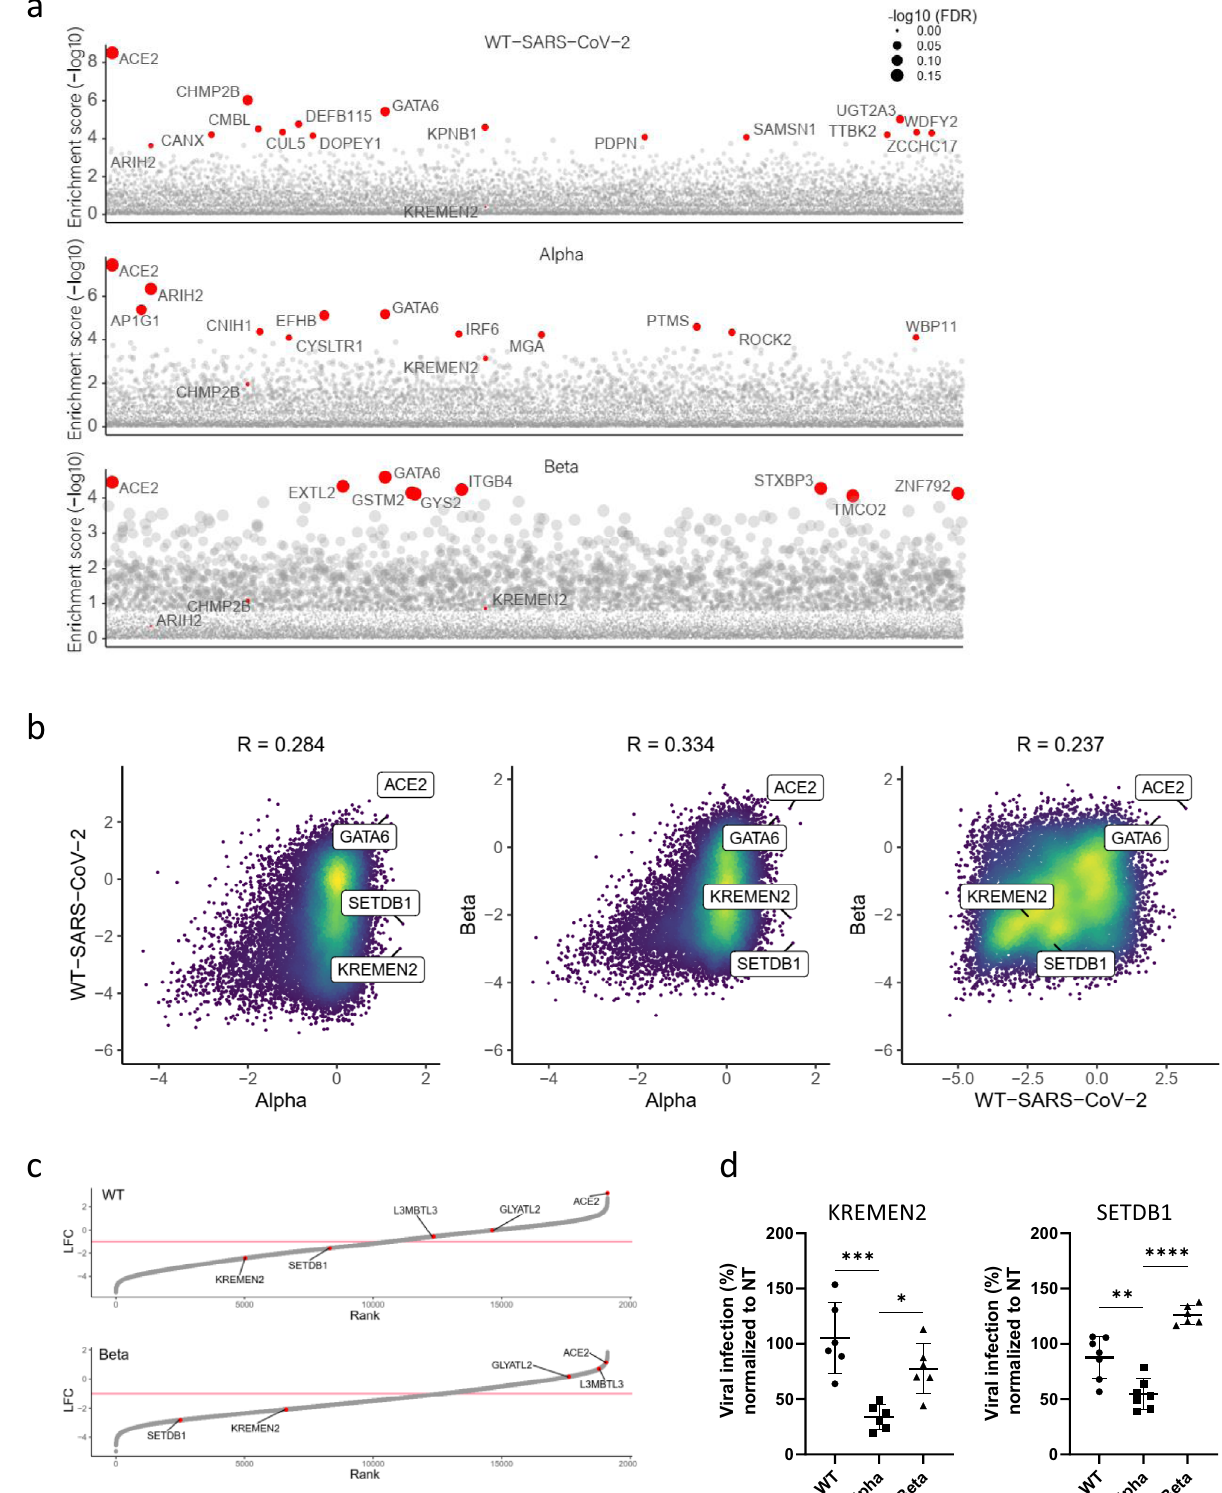
impaired infectivity in the GATA6 KO cells con fi rming the strain- independent essentiality of GATA6 for SARS-CoV-2 infection. As mentioned, previously published mRNA-seq transcriptomic datasets of Calu-3 59 , A549 60 , and Vero-E6 61 cell lines, revealed that GATA6 is expressed at much higher levels in Calu-3 cells (Fig. 1g), suggesting that GATA6 was not identi fi ed in